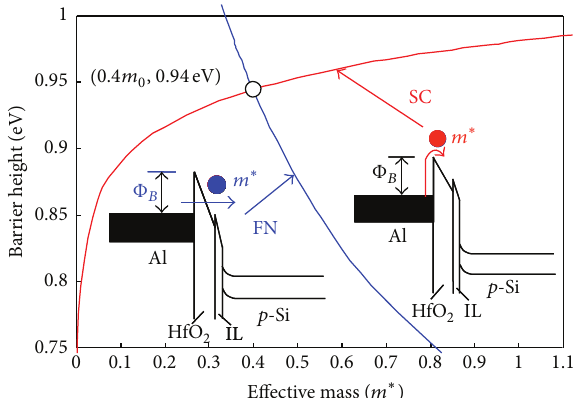
Figure 7: The extracted relationships between electron effective mass and Al/HfO 2 barrier height from the intercept of the Schottky plot at a high temperature (465K) and the slope of the F-N plot at a low temperature (77K). The band diagrams for the Schottky emission and F-N tunneling are also shown.